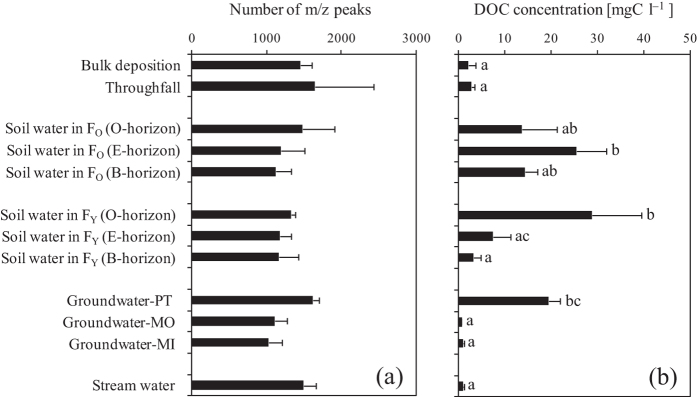
(a) Average values for the number of m/z peaks and (b) DOC concentration in bulk deposition, throughfall, soil water, groundwater, and stream water during the study period. Error bars represent standard deviations. Values with the same letter indicate no significant difference (p > 0.05). FO and FY represent old-growth forest and young plantation stands, respectively. See Methods for the abbreviations of groundwater.